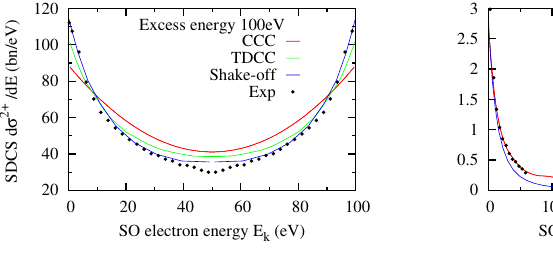
Figure 2. The energy resolved DPI cross-section of helium d σ 2 + / dE ) (in bn/eV) at the excess energies above the DPI threshold E = 100, 450 and 720 eV (from left to right). The present shake-off calculations using Equation (3) are compared with the following reference data. At E = 100 eV, the relative measurement [33] is normalized to the TDCC calculation [34] and shown along with an analogous CCC calculation [35]. At E = 450 eV, the relative experiment [7] is normalized to the CCC calculation from the same reference. At E = 720 eV, the TDCC [36] and the CCC [11] calculations are